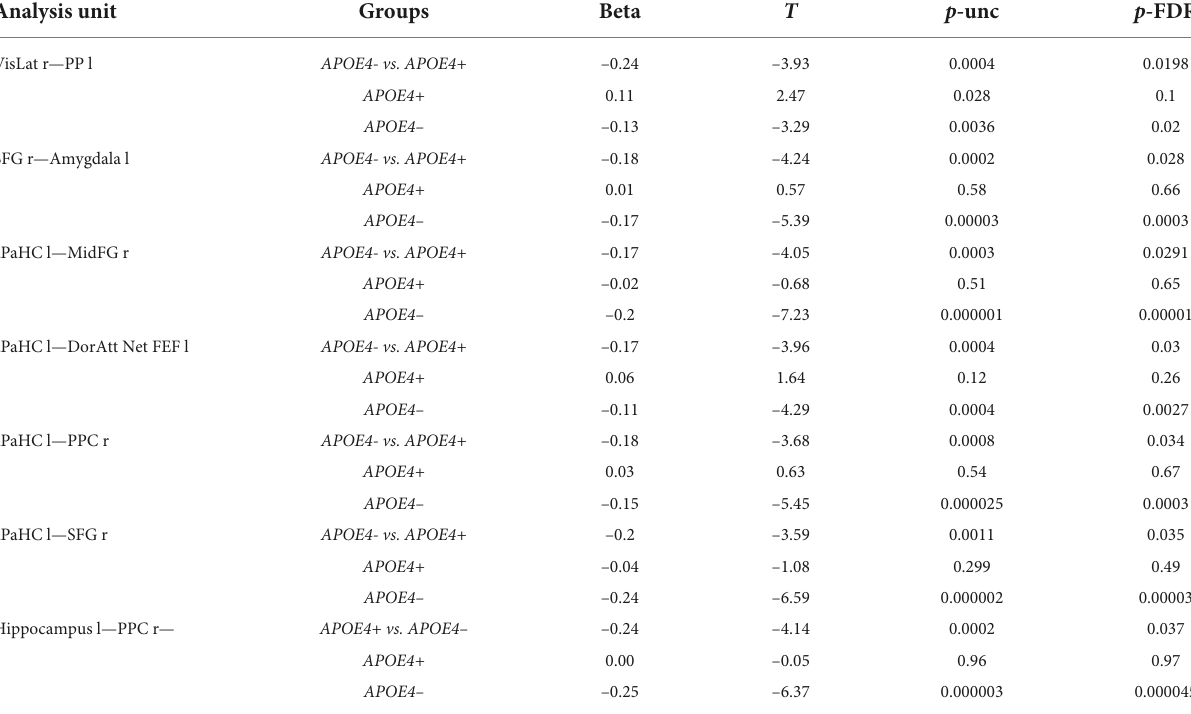
TABLE 4 ROI-to-ROI resting-state functional connectivity (rsFC) according to fMRI of the APOE4+ and non-carriers. Analysis unit Groups